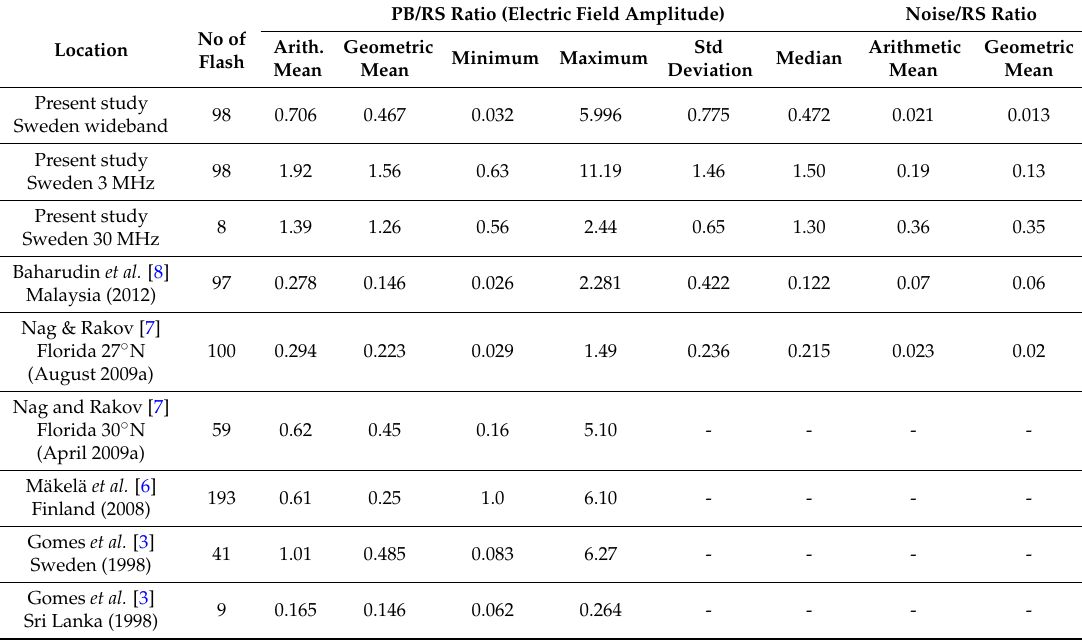
Table 3. Preliminary breakdown (PB) to return stroke (RS) electric field peak ratio.